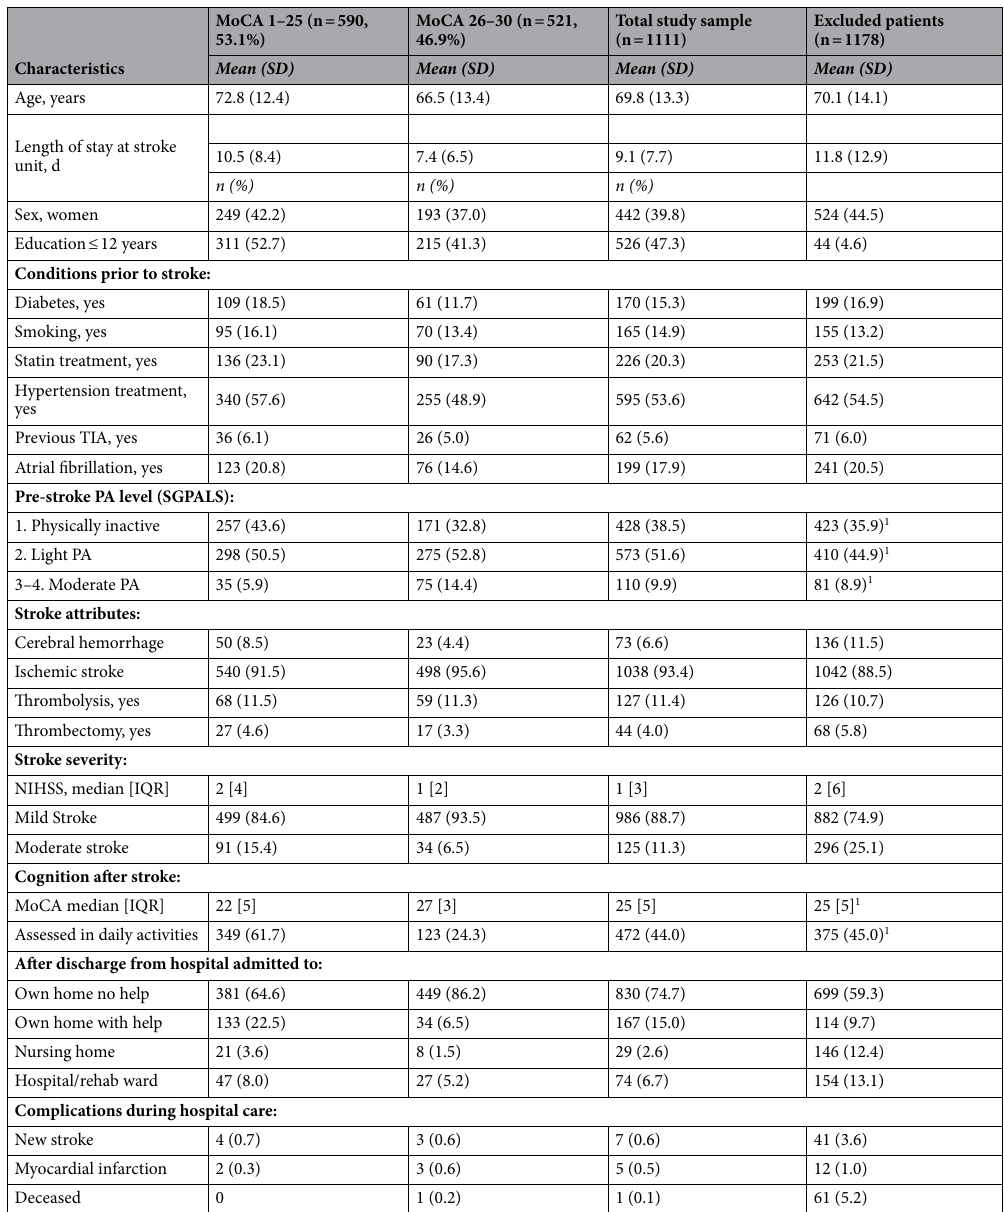
Table 1. Descriptive characteristics of the study sample, presented in groups based on cognitive function, (cognitive impairment MoCA 1–25, and intact cognition MoCA 26–30) screened using the Montreal Cognitive Assessment (MoCA). Percent (%) as valid percent. N indicates numbers; SD, standard deviation; IQR, interquartile range; d, days; PA, physical activity; TIA, transient ischemic attack; NIHSS, National Institutes of Health Stroke Scale with mild stroke (0–5), and moderate stroke (6–14); SGPALS, Saltin-Grimby Physical Activity Level Scale. Missing in study sample (n = 1111): length of hospital stay at the stroke unit (n = 61), diabetes (n = 1), smoking (n = 82), statin treatment (n = 2), hypertension treatment (n = 1), previous TIA (n = 5), new atrial fibrillation (n = 1), thrombolysis (n = 4), thrombectomy (n = 45), assessment in daily activities not appropriate (n = 305), after discharge from hospital admitted to (6), new stroke (n = 12), myocardial infarction (n = 7). 1 Indication of more than 20% internal missing values in the group of excluded